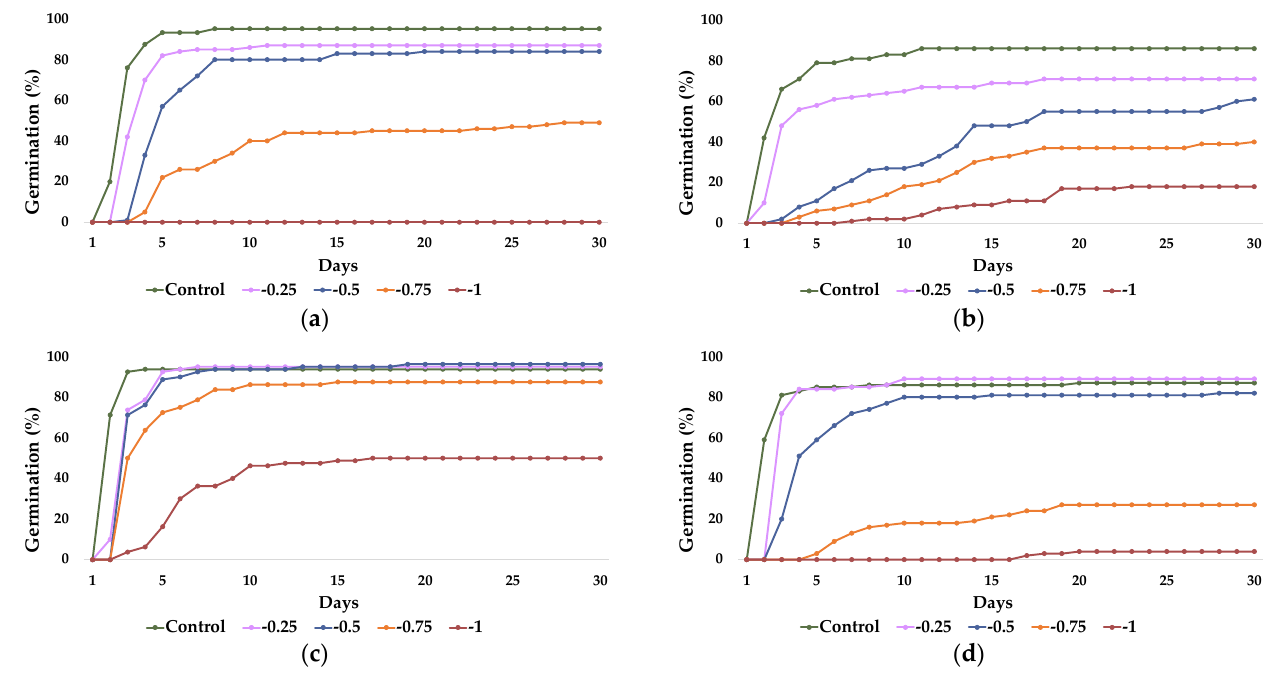
Figure 2. Evolution of seed germination over 30 days of osmotic stress treatments using PEG at the indicated concentrations, expressed as osmotic potential (MPa), in ( a ) C. citratus , ( b ) C. selloana , ( c ) P. alopecuroides , and ( d ) P. setaceum . Means of cumulative germination percentages of four technical replicas (plates) are presented for each treatment and species. Control: germination in distilled water. Upon PEG application for 30 days, the final germination percentages decreased in all four investigated species (Figure 3). However, their sensitivity to osmotic stress varied, with P. alopecuroides seeds being the most tolerant (Figure 3c). Up to − 0.5 MPa PEG, the highest germination percentage seen in the control was maintained; however, − 0.75 MPa caused it to be somewhat lowered (10%), and − 1 MPa caused it to drop to roughly 50%. For the other three species, final germination percentages decreased gradually in parallel with increasing PEG concentrations. This reduction was modest in C. citratus (Figure 3a) and P. setaceum (Figure 3d) at − 0.25 and − 0.5 MPa, but it was considerable at − 0.75 MPa (55% and 70%, respectively).